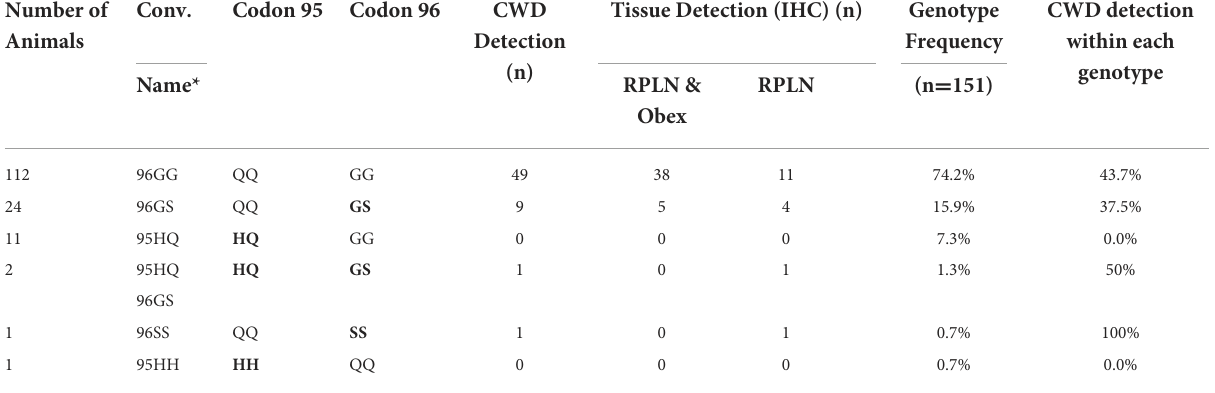
TABLE 3 Detection of CWD in animals with immunohistochemistry (IHC) in white-tailed deer with different genotypes. Number of Animals